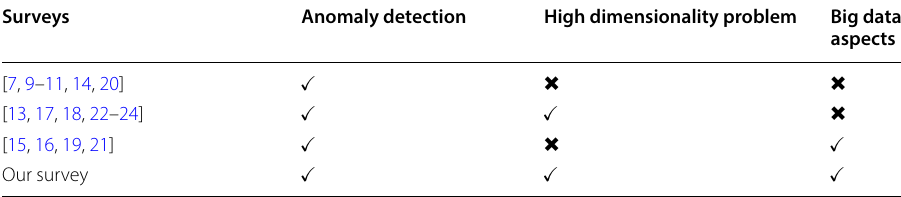
Table 1 Comparison of our survey to other related survey articles Surveys Anomaly detection High dimensionality problem Big data